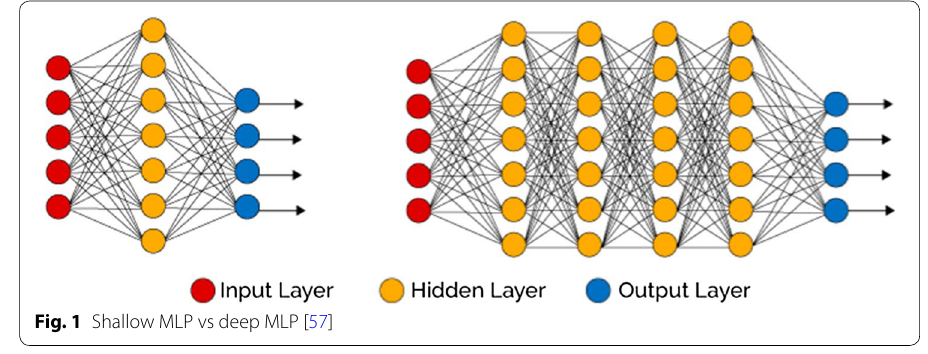
Fig. 1 Shallow MLP vs deep MLP [57]